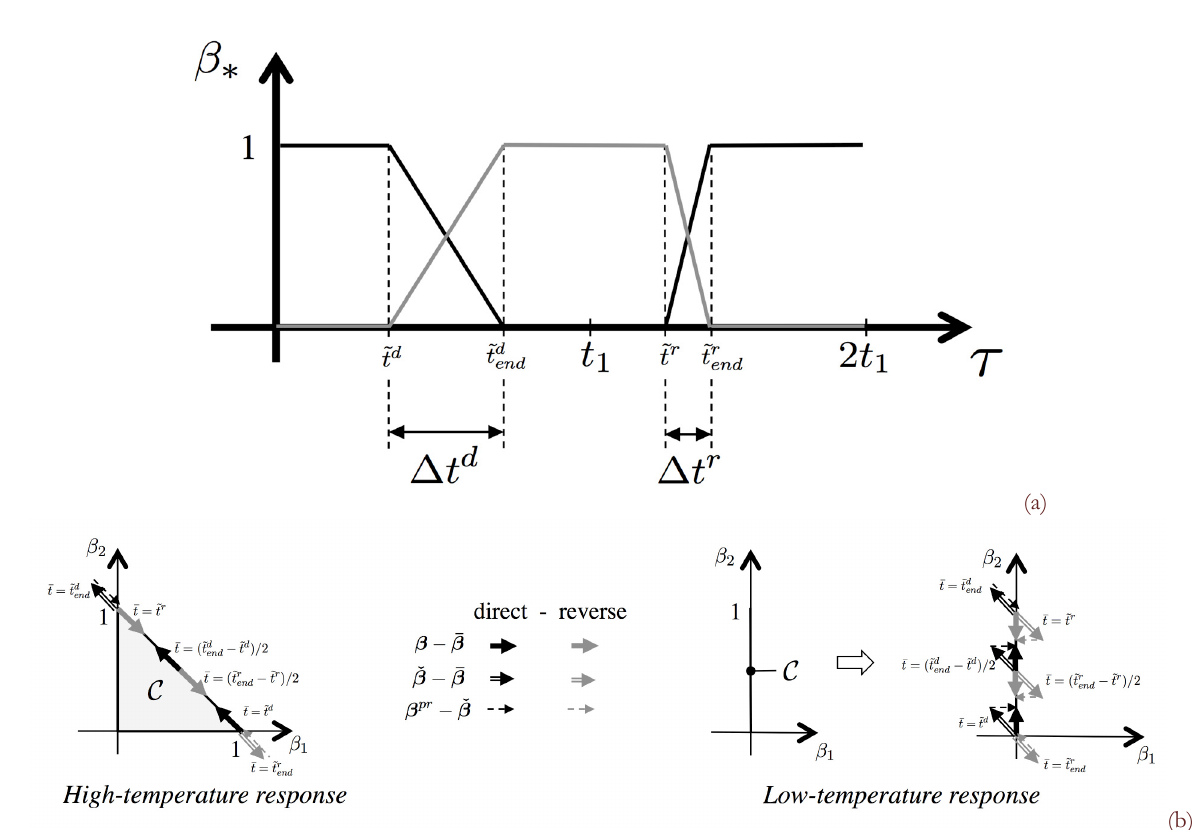
 vs.  . (b) T ); in grey, 1 2